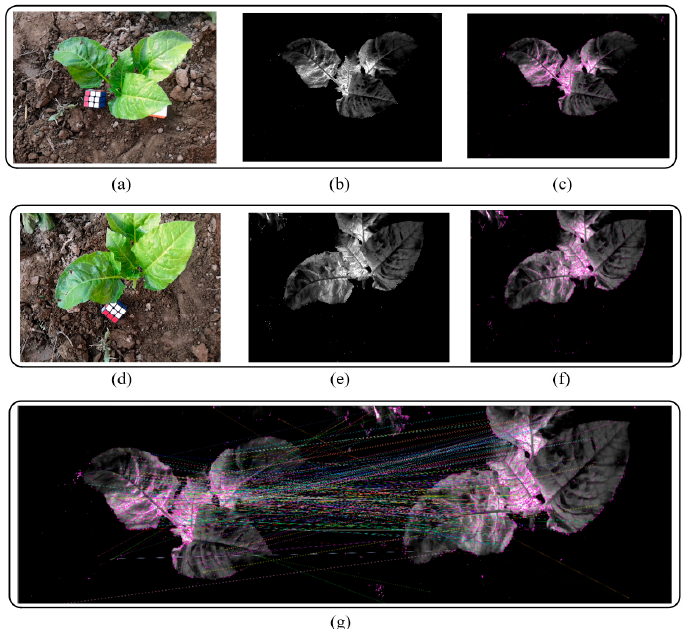
Figure 3. Key frame extraction. ( a , d ) original images; ( b , e ) ExGR images, ( c , f ) scale-invariant feature transform algorithm (SIFT) feature images; ( g ) matching image.